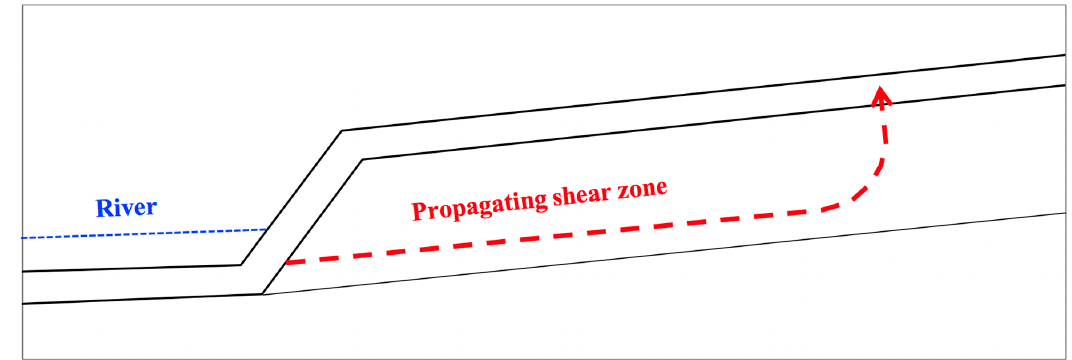
Figure 2. Development of a failure surface via a weak zone caused by progressive erosion at the foot of the slope [12].